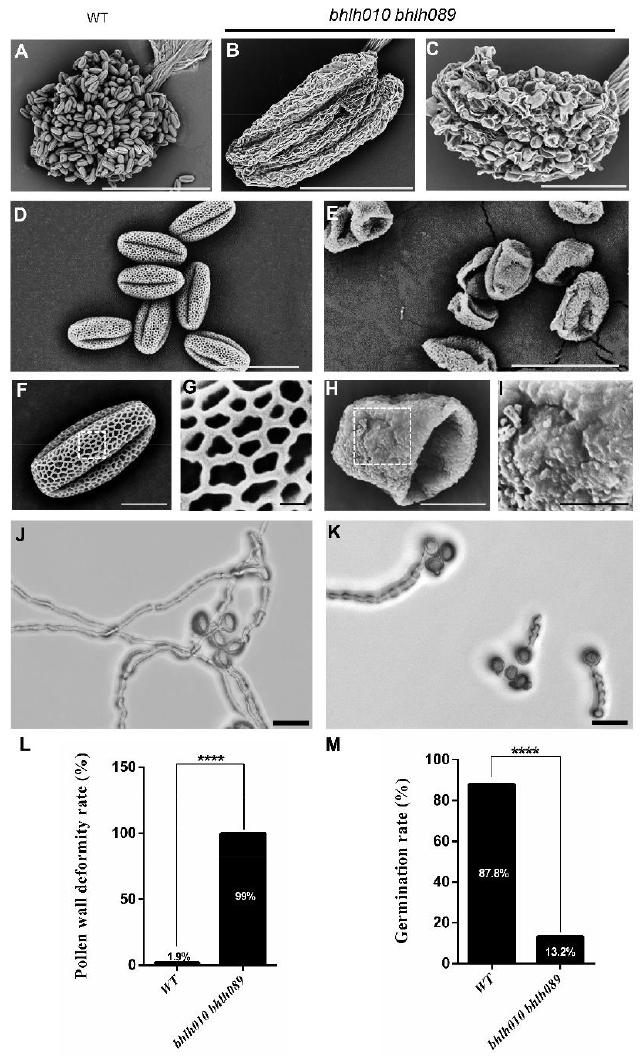
Figure 1. The pollen development of a bhlh010 bhlh089 double mutant was severely malformed. ( A – C ) The anthers of WT and bhlh010 bhlh089 double mutants were observed by scanning electron microscopy (SEM). ( A ) The anther of WT flower. Bar = 200 µ m. ( B ) The anther of the bhlh010 bhlh089 early flower. Bar = 200 µ m. ( C ) The anther of bhlh010 bhlh089 late flowers. Bar = 100 µ m. ( D – I ) SEM of pollen gains of the WT ( D ) and bhlh010 bhlh089 ( E ) pollen. ( F , H ) Pollen exine structure of WT ( F ) and bhlh010 bhlh089 ( H ). Bars = 20 µ m. ( G , I ) SEM images of enlarged exine surface of WT ( G ) and bhlh010 bhlh089 ( I ) pollen. Bars = 10 µ m. ( J , K ) Pollen germination of the WT ( J ) and bhlh010 bhlh089 ( K ) plants. Bars = 50 µ m. ( L , M ) Statistic analysis of the rate of pollen with defective exine phenotype ( L ) and the germination rate ( M ) of the WT and bhlh010 bhlh089 plants. The asterisks in ( L , M ) indicate a statistically significant difference from the WT control (****, p < 0.0001, Student’s t